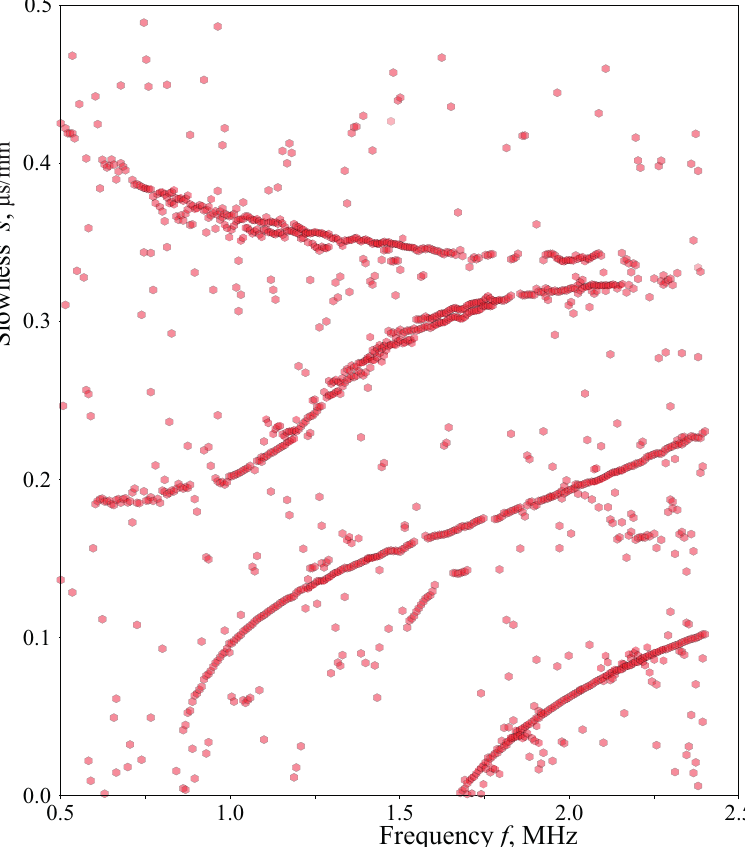
Figure 2. The slownesses calculated for 2 mm thickness aluminium plate using the MPM at M = 6. The amplitudes A n